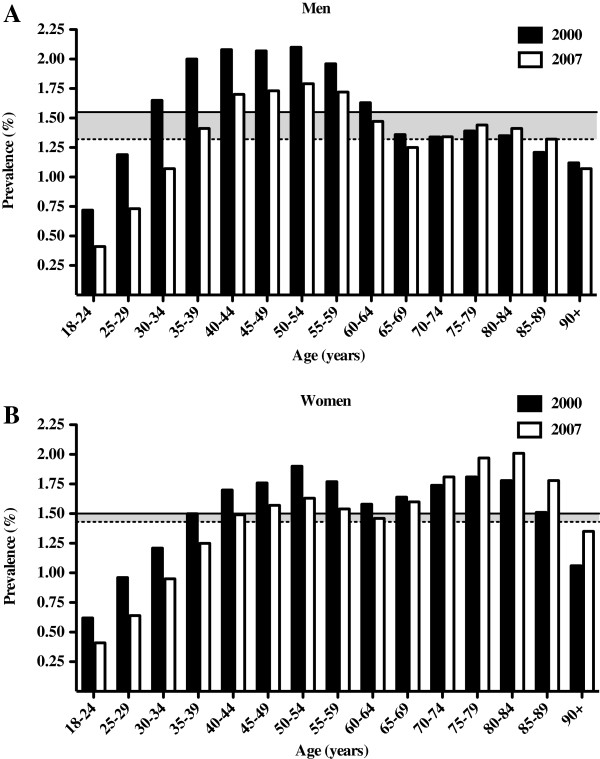
Annual prevalence of claims-based recurrent low back pain in 2000 and 2007 by age categories and sex. A) Profile of the male cohort prevalence. The mean prevalence in 2000 (solid line) is higher than in 2007 (dotted line). B) Profile of the female cohort prevalence. The mean prevalence in 2000 (solid line) is slightly lower than in 2007 (dotted line).